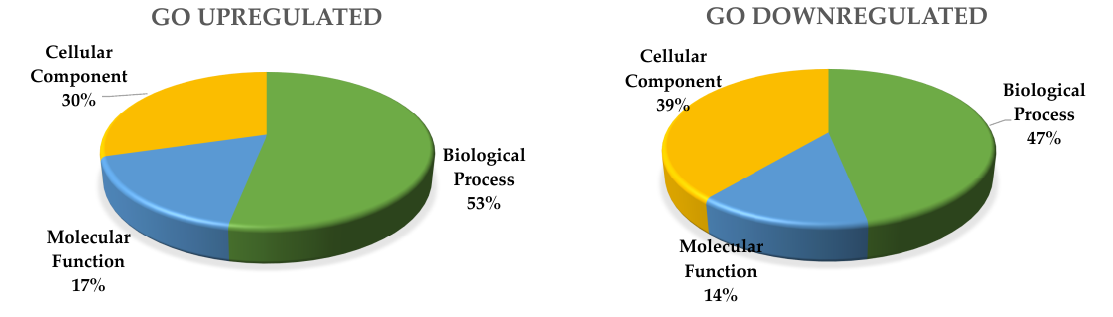
Figure 2. Cellular components regulated during MTs development of potato induced in the dark. 2.2. TFs Overall, 112 up-regulated and 145 down-regulated TFs were found in the tran- scriptomic-wide analysis of MTs induced under dark conditions. 2.2.1. Up-regulated TFs Up-regulated TFs are related to C2H2-type zinc finger (20), F-box (15), bHLH (13), AP2 ERF (13), MYB (10), GATA (6), ZF-HD protein (3), Basic leucine zipper (5), bZiP (5), B3 DNA binding d2ggomain (5), NF-Y (4), WRKY (3), TCP (2). The PPI network of up-regulated TFs made on the STRING data base v11.5 with me- dium confidence revealed that 23 out of 112 TFs interact (Figure 3), while 14 interact with at least 1 TF. The list of up-regulated TFs interacting in the PPI network and levels of gene regulation are shown in the heat-map (Figure 4).